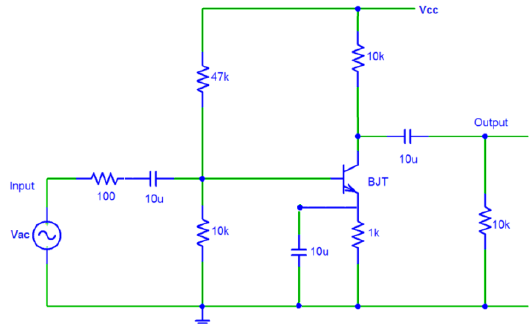
Figure 10. HRG gyroscope excitation circuit.